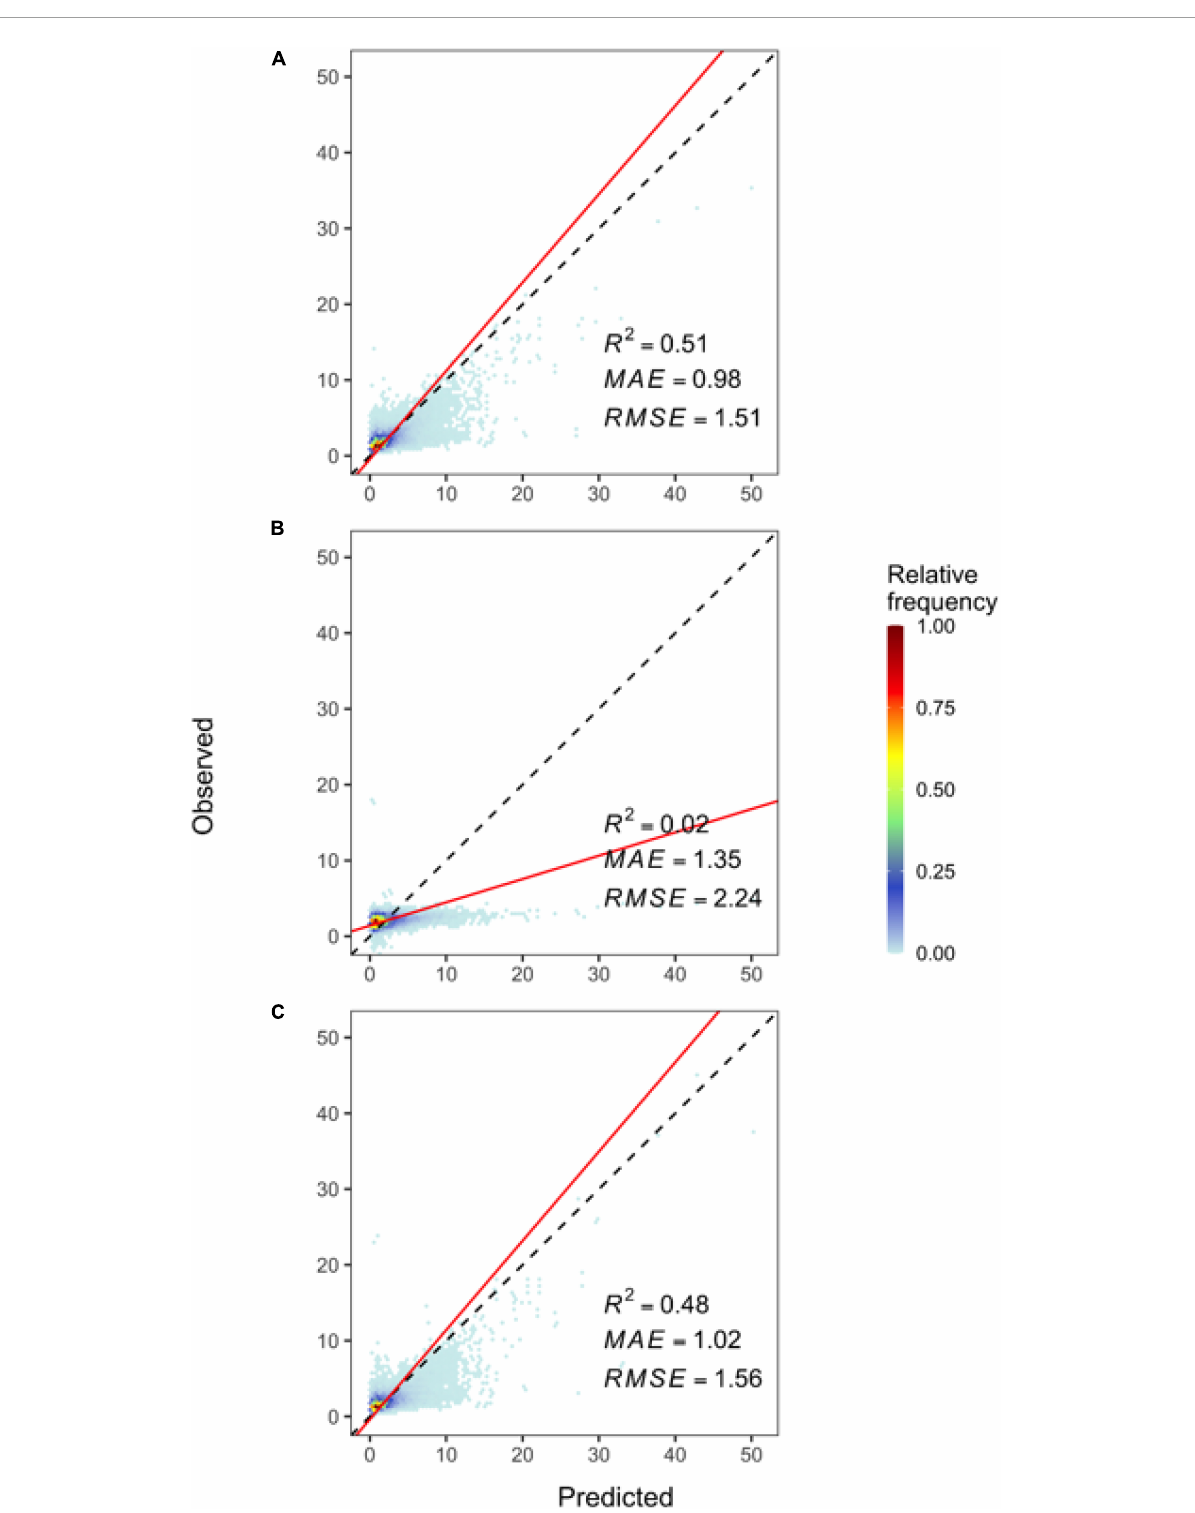
Frontiers in Forests and Global